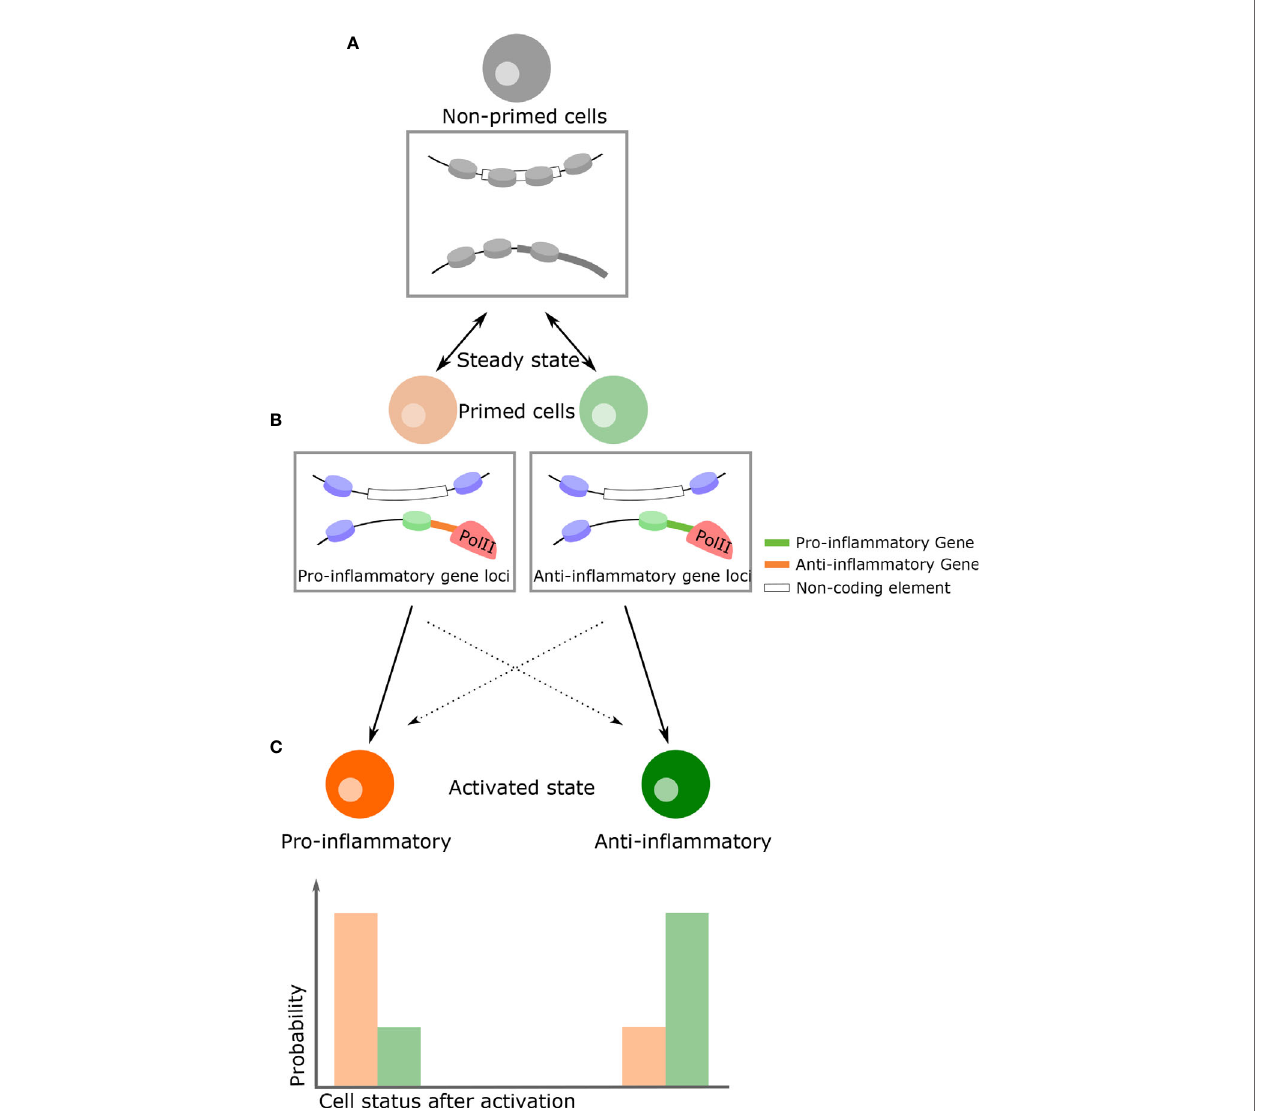
FIGURE 3 | A proposed model of how genome structure in fl uences phenotypic consequence. (A) In the naïve state, all in fl ammatory cells are almost indistinguishable with regards to their transcriptional pro fi les and durable epigenetic changes have yet to take place. (B) Due to thermodynamic fl uctuations, however, some cells become primed states transiently at various possible loci. Chromatin structural changes by means of external signals, for example NO as a paracrine signal, can favor a primed state with speci fi c characteristics. (C) If cells encounter activation signals in this primed state, there is a high probability they will become a speci fi c phenotype following activation. For example, pro-in fl ammatory primed cells become pro-in fl ammatory cells (and vice versa). On the other hand, owing to the intrinsic stochasticity of all transcription, primed cells can become the opposing phenotype (i.e. in fl ammatory or anti-in fl ammatory), although this probability is lower. Rectangular insets below cells diagrams is a representation of the chromatin changes which might occur at speci fi c gene